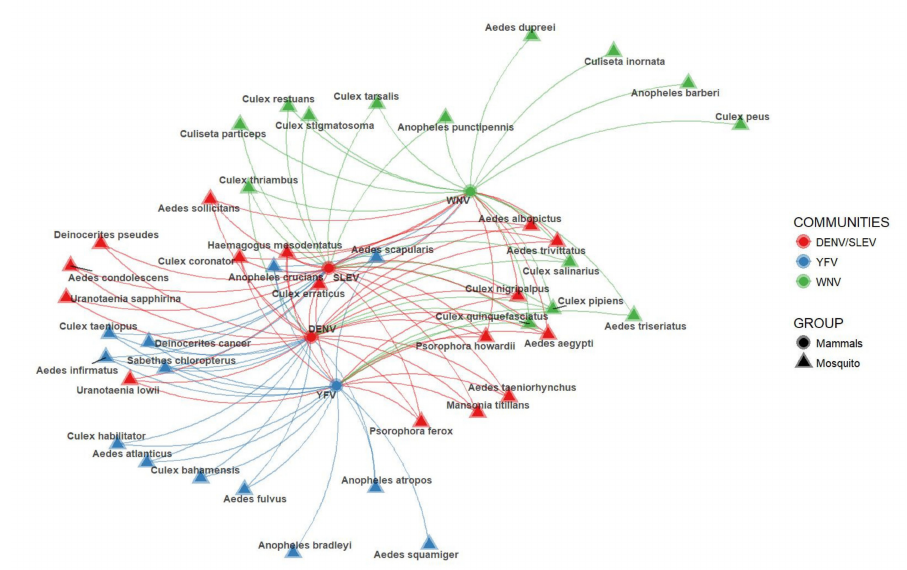
Figure 2. Louvain community detection by grouping mammals per pathogen.